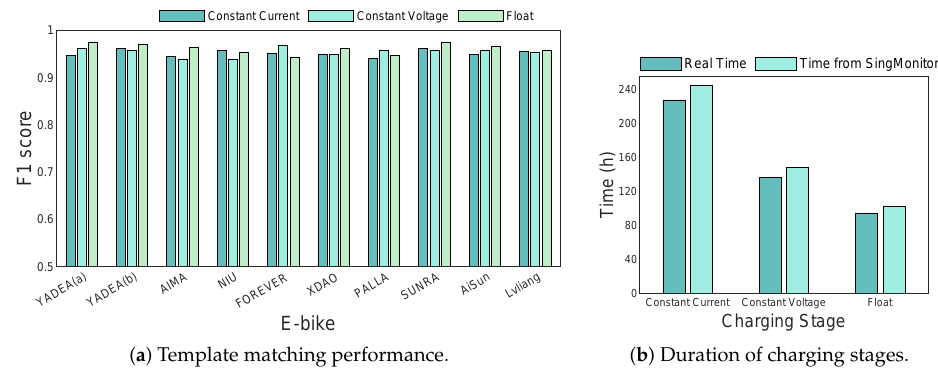
Figure 14. Overall performance of SingMonitor